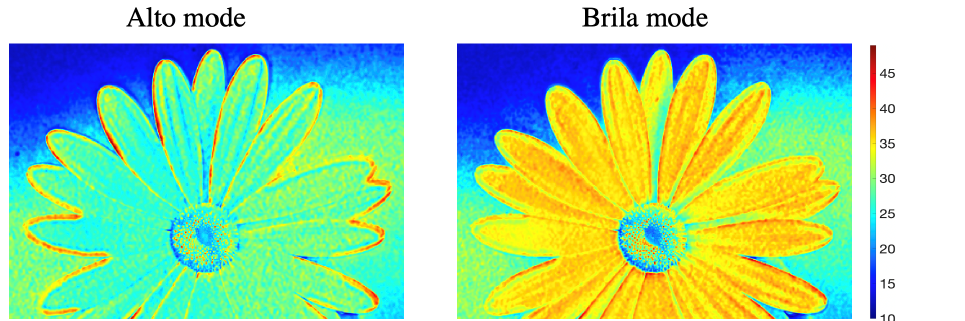
Figure 12. SCIELAB’s mean quality maps of the flower image for the Alto mode ( left ) and the Brila mode ( right ) prints from the MS captures. The maps were cropped for illustration purpose. Zero means there is no